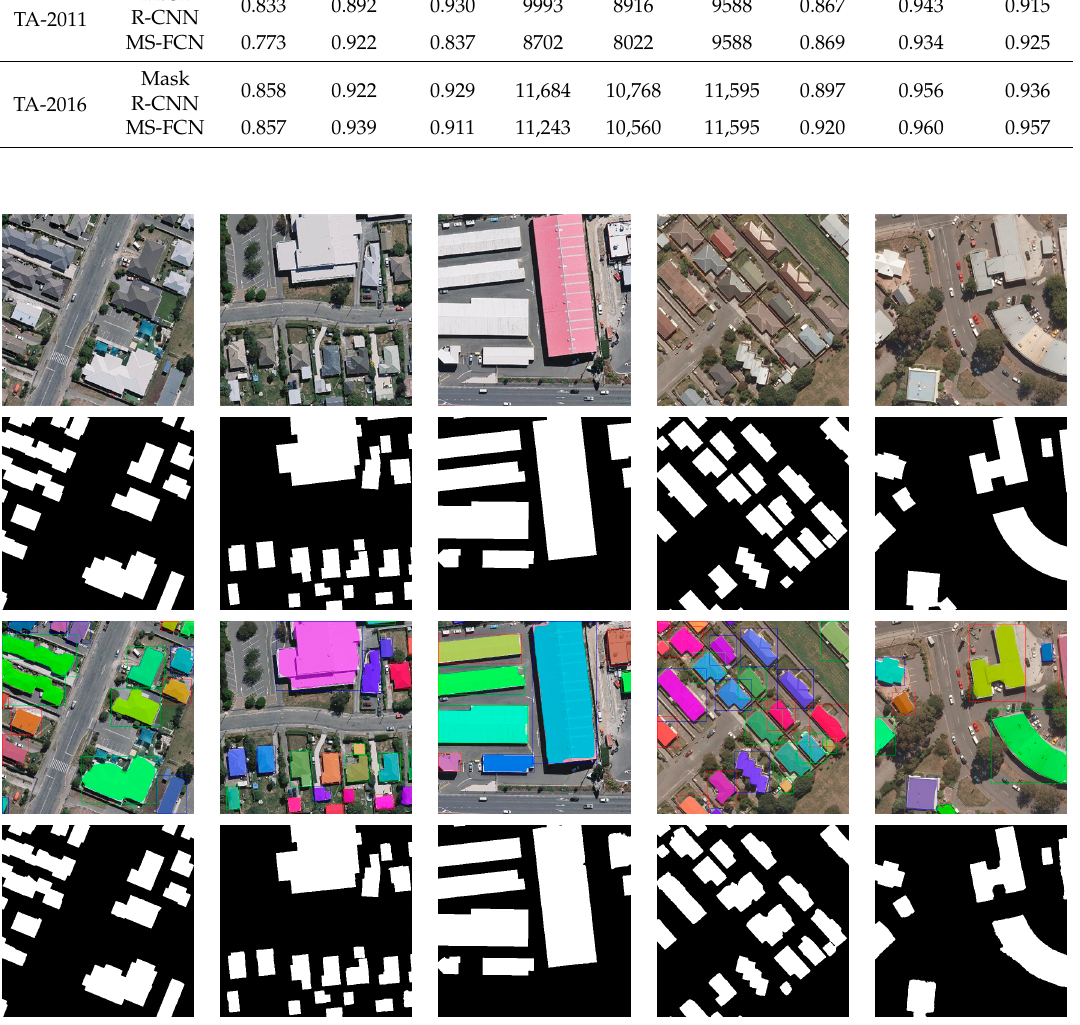
Figure 9. Examples of building extraction results of the Mask R-CNN and MS-FCN. From top to bottom: image, label, results of the Mask R-CNN, results of the MS-FCN. From left to right: columns